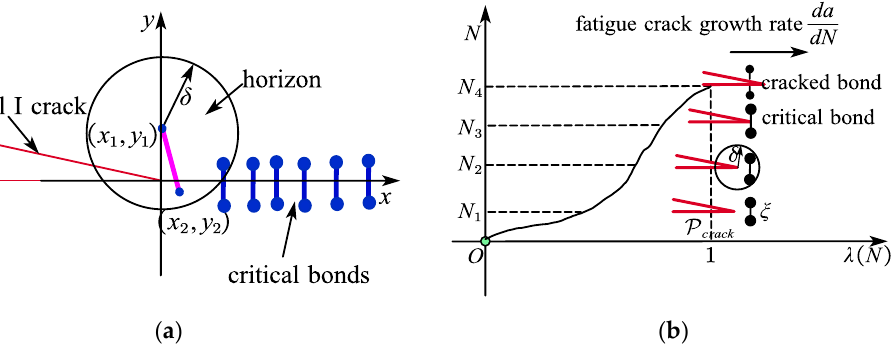
Figure 8. The peridynamic fatigue crack under bending loads. ( a ) The critical bond in the model I crack. ( b ) The bond breaks in a progressive way.